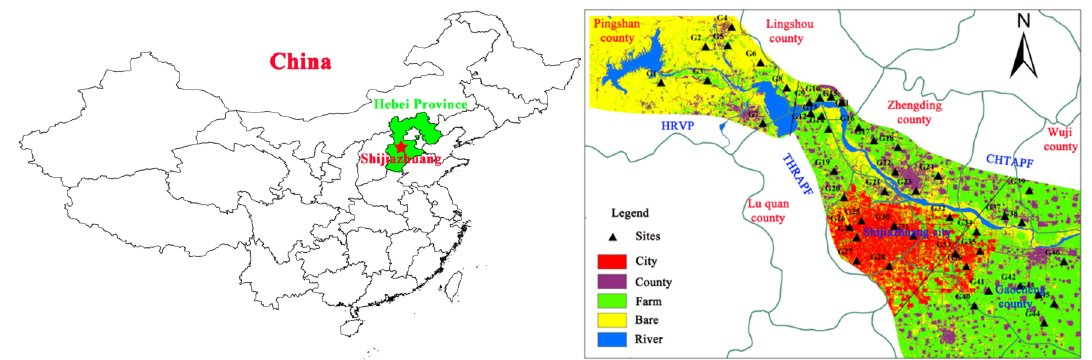
Figure 1. Monitoring sites of groundwater in Hutuo River alluvial-pluvial fan.